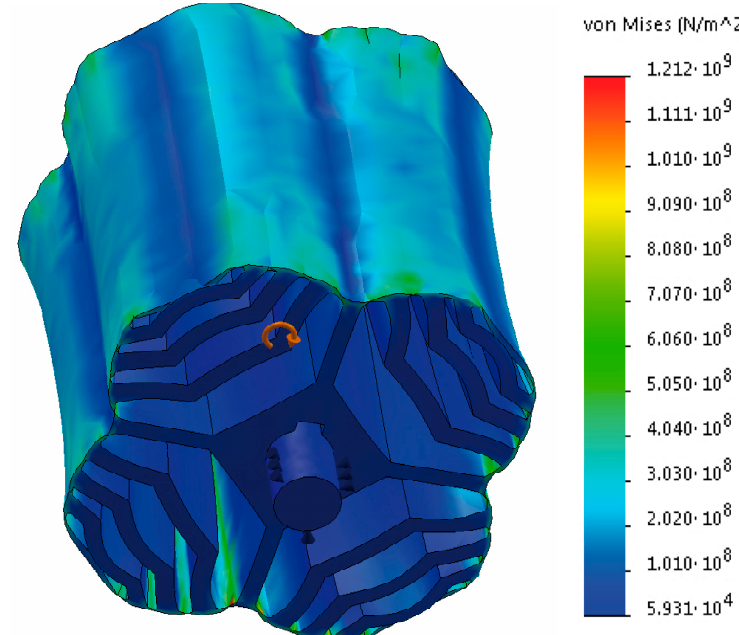
Figure 3. Pattern of distribution of mechanical stresses under the action of centrifugal forces.